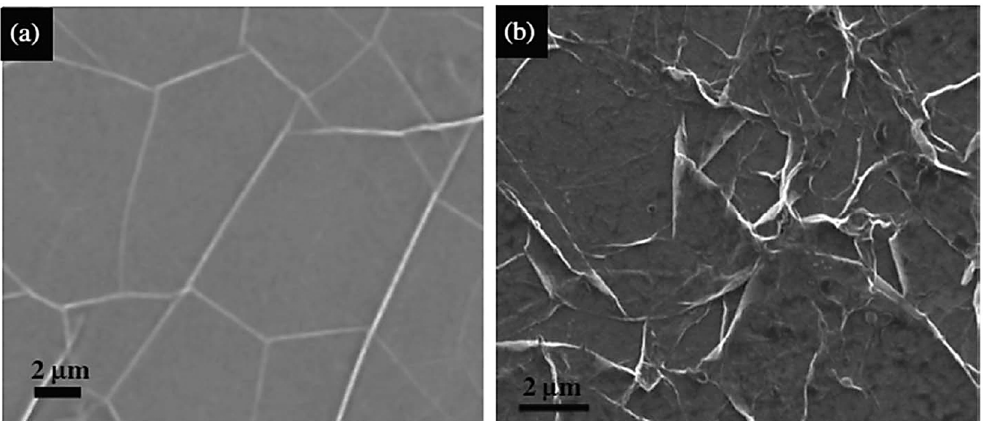
Figure 8. SEM micrograph of a Gp with seven layers on ( a ) Cu substrate and ( b ) Si substrate. Reprinted with permission from [60]. Copyright RSC Publishers, 2017.